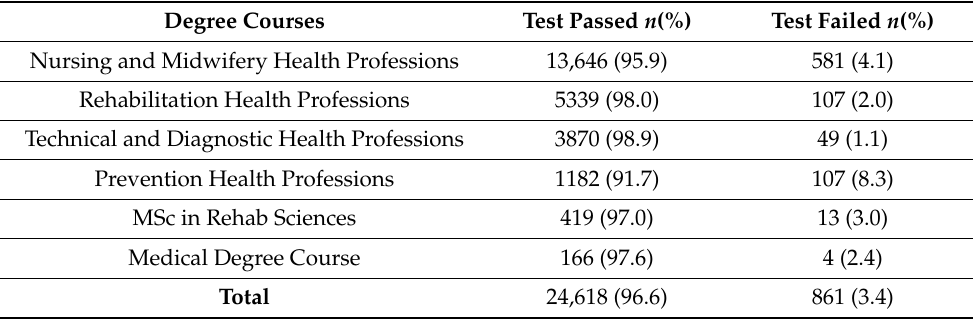
Table 3. Percentage of students who passed the test.